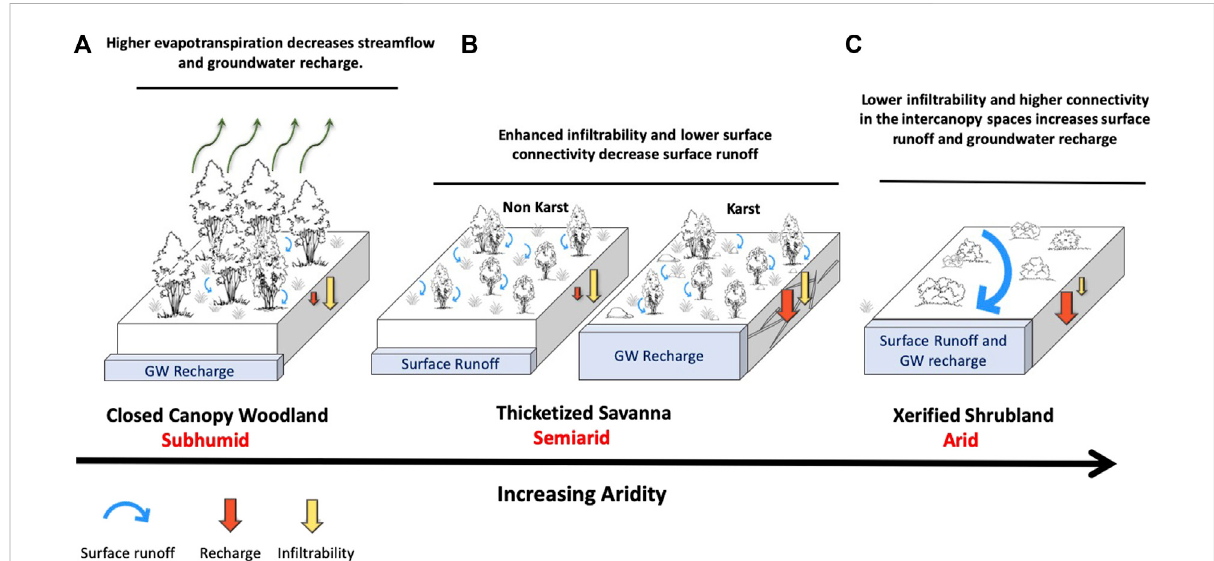
FIGURE 5 Conceptualized framework for understanding how woody plant encroachment modi fi es ecohydrological processes. (A) . Closed Canopy Woodlands: In subhumid climates (aridity index 0.5 – 0.7) woody encroachment will result in higher evapotranspiration leading to lower stream fl ows andgroundwaterrecharge. (B) . ThicketizedSavannas: insemiaridclimateswhererainfallissuf fi cienttomaintainvegetatedintercanopyareas(aridity index 0.2 – 0.5) woody encroachment enhances in fi ltrability (lower connectivity) resulting in less surface runoff. Where substrate is highly permeable such as karst landscapes, groundwater recharge may be increased. (C) . Xeri fi ed shrublands: in arid climates (aridity index < 0.2) woody encroachment increases landscape connectivity because of interconnected bare intercanopy patches. As a result surface runoff is increased as is groundwater recharge as a result of higher transmission losses in stream